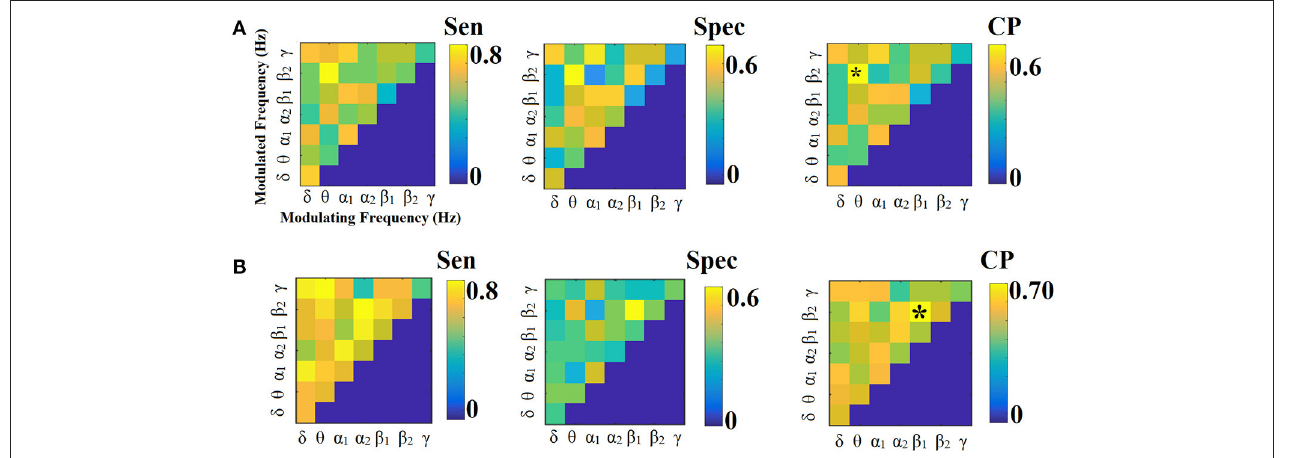
FIGURE 3 | Sensitivity, specificity and classification performance of CorrEnv using PCA ROI representation and edge-weights approach of each SL-FCG. (A) Sensitivity, specificity and classification performance for the LOOCV. (B) Sensitivity, specificity and classification performance for the 5-fold CV. * denotes the best CP for each CV scheme. Sen, sensitivity; Spec, specificity; CP, Classification